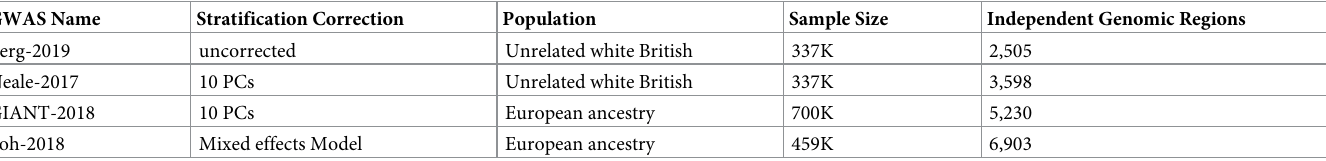
Table 2. GWASs on standing height used to evaluate robustness of our approach. We used four published GWASs performed in the UK Biobank on standing height to evaluate the robustness of our approach. The year in the name is when the GWAS was published. Any correction for population stratification (“Stratification Correc- tion”) and the specific GWAS population (“Population”) is noted. Using the same criteria for LD-pruning (Methods), we identified independent trait-associated genomic regions (“Independent Genomic Regions”). The Loh-2018 (40) GWAS used a linear mixed model (BOLT-LMM) shown to be robust against population stratification